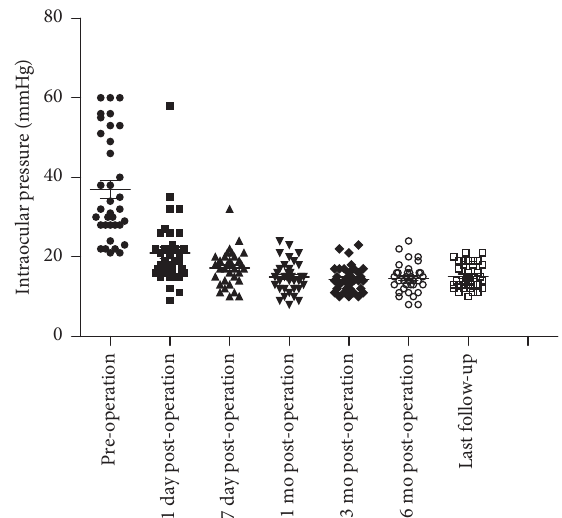
Figure 2: Scatter gram of intraocular pressure before and after cyclophotocoagulation, with postoperative assessments at 1 day, 7 days, 1 month, 6 months, and the last follow-up.